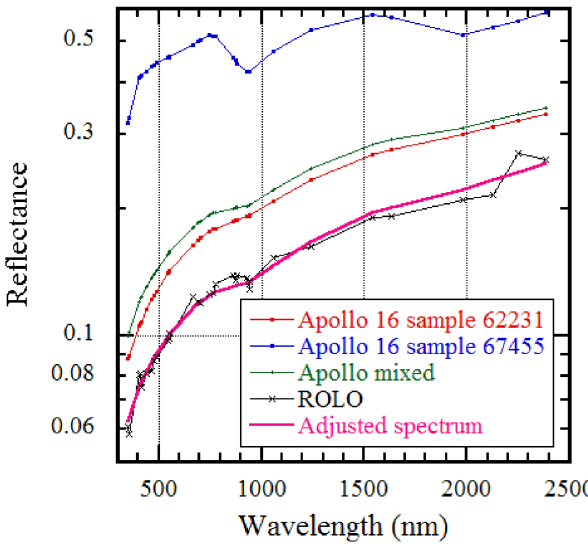
Figure A1. Coefficients for smoothing at the ROLO 32 wavelength.